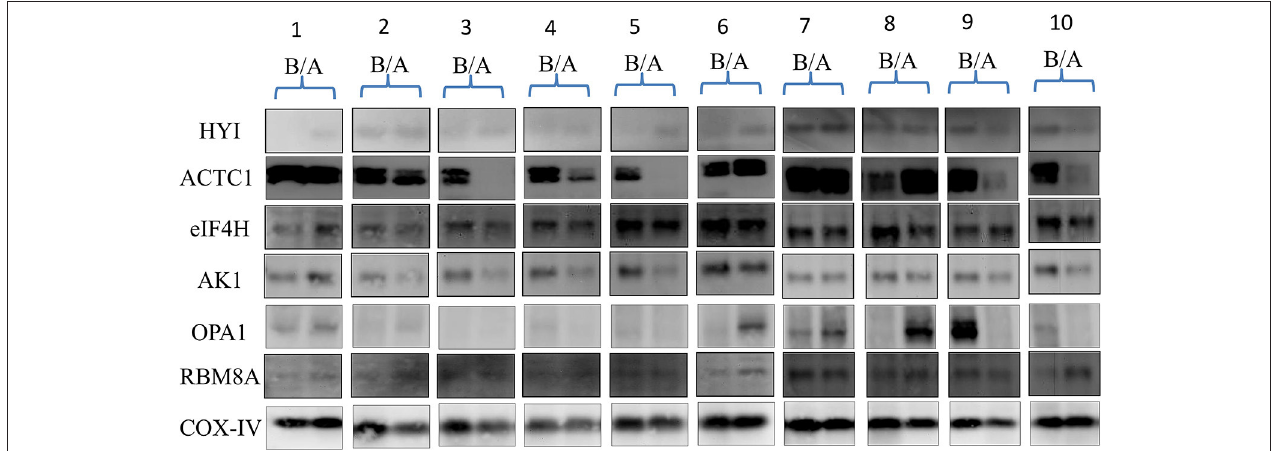
FIGURE 1 | Western blots of 10 MDD patients with paroxetine reponse, before and after antidepressant treatment. A, after treatment; ACTC1, alpha cardiac muscle 1 actin; AK1, adenylate kinase isoenzyme 1; B, before treatment; COX-IV, cytochrome c oxidase subunit IV, as control; EIF4H, eukaryotic translation initiation factor 4H; HYI, putative hydroxypyruvate isomerase; MDD, major depressive disorder; OPA1, mitochondrial dynamin-like 120 kDa protein; RBM8A, RNA binding motif